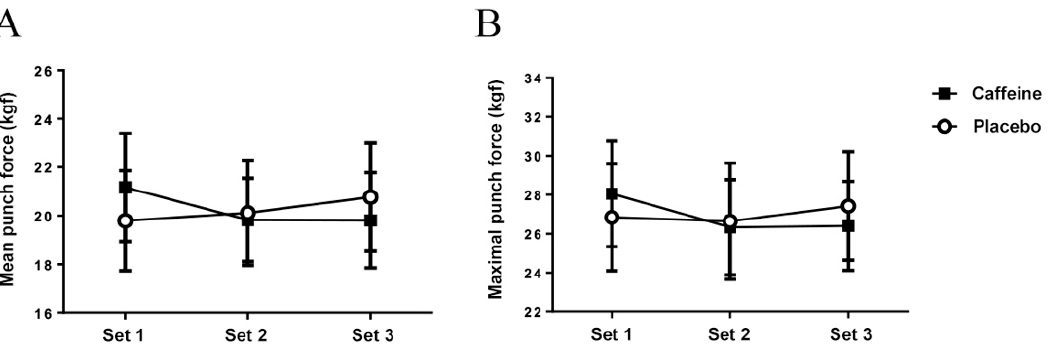
Figure 2. ( A ) Mean punching force. ( B ) Maximum punch force.